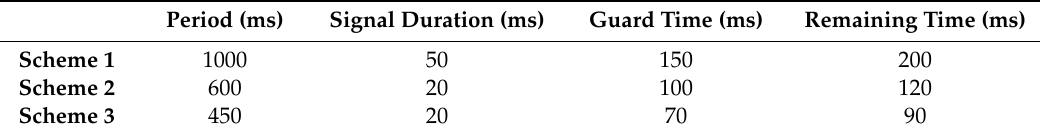
Figure 11. TDMA-only transmission scheme.